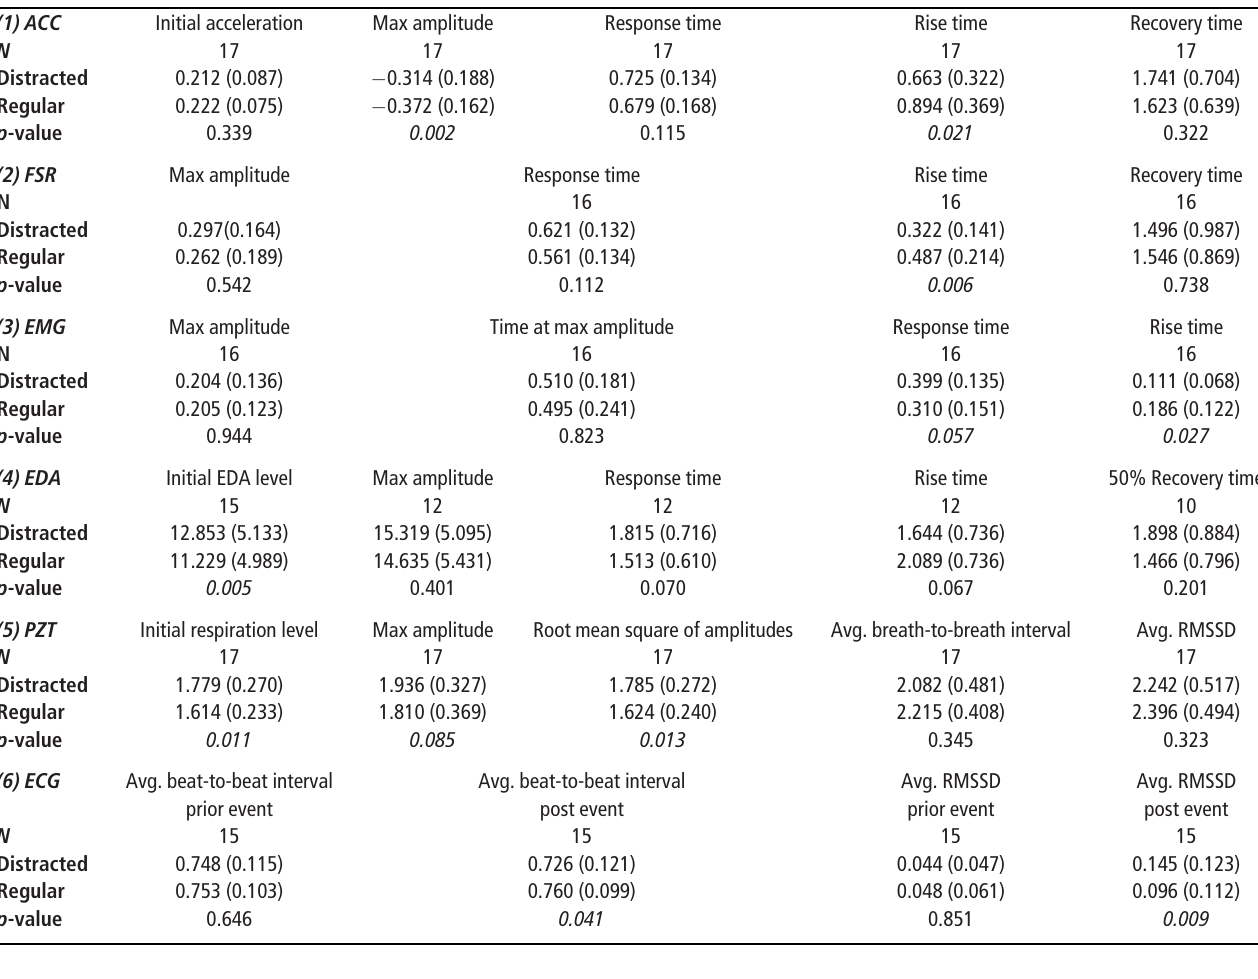
Table 4 Summary of the physiological signal